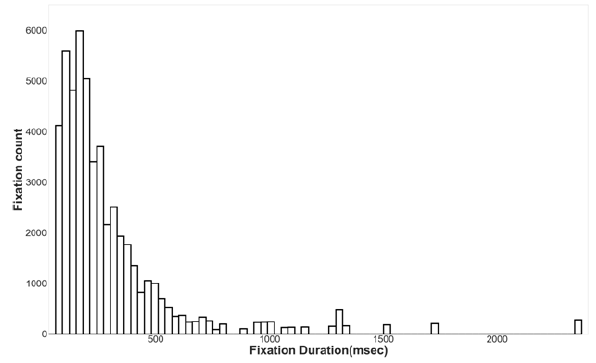
Figure 1. Representative frequency distribution of raw fixation durations (n = 51238) from a single